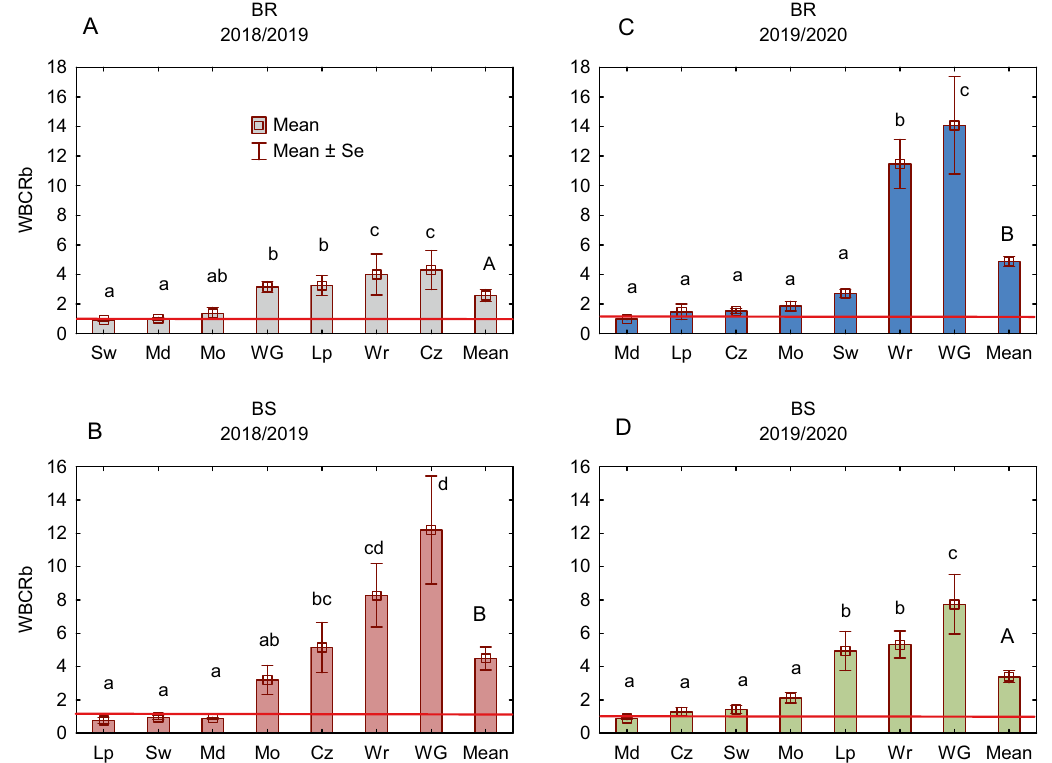
Figure 5. The competitive ratio for biomass production (WBCRb) between winter wheat and herbicide- resistant (BR)/susceptible (BS) blackgrass in the years of study for seven sites in Poland. Competitive ratio values < 1 indicate that blackgrass is more competitive than